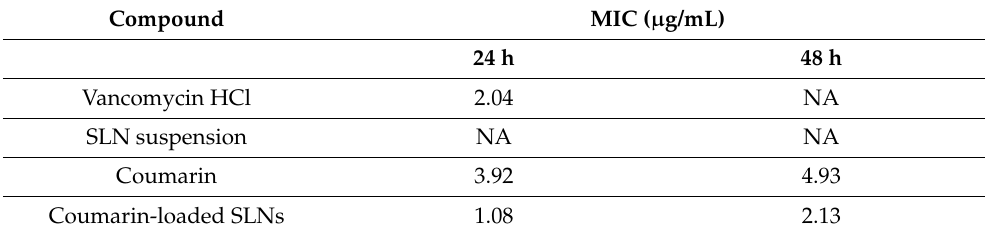
Table 1. Comparative minimum inhibitory concentration.